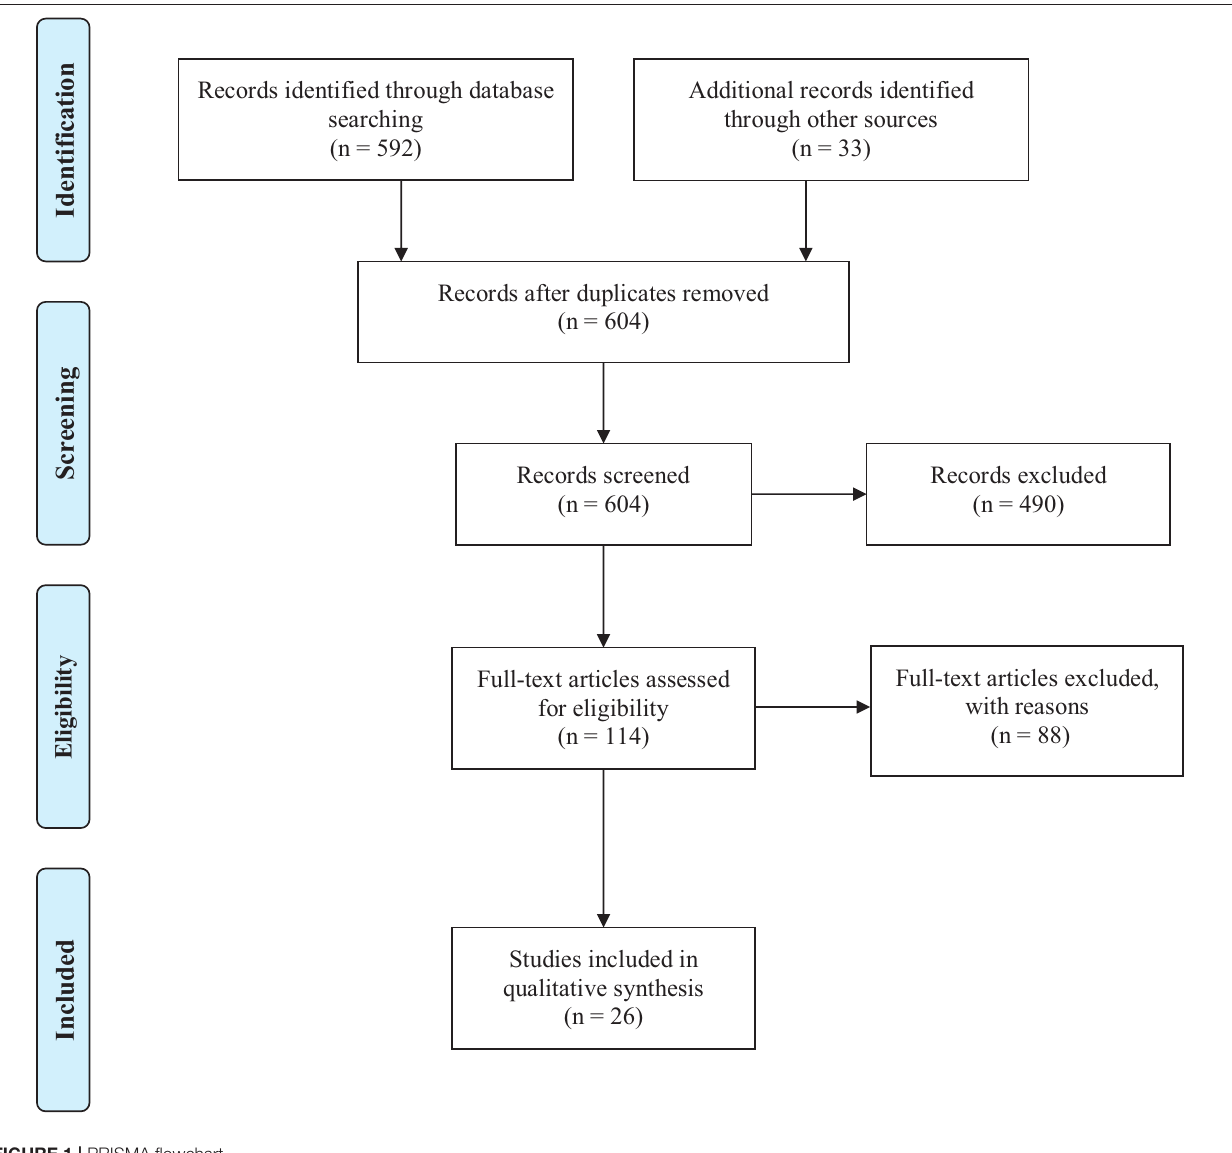
FIGURE 1 | PRISMA